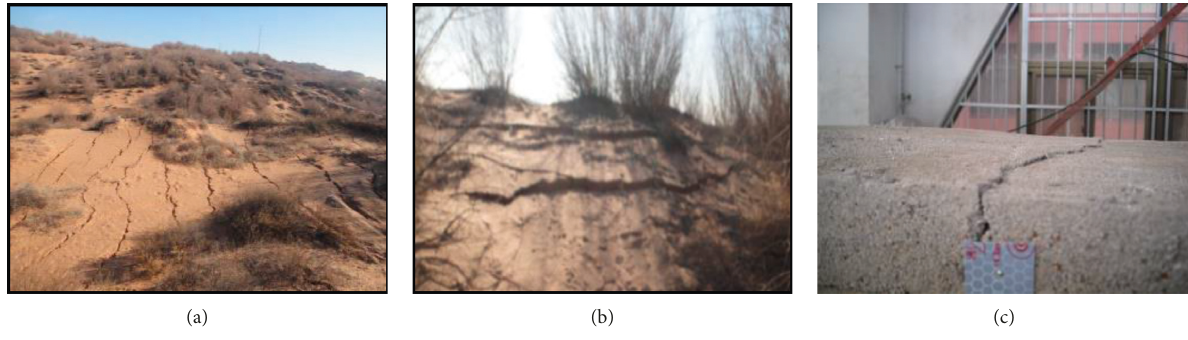
Figure 5: The surface cracks of 22407 working face and physical